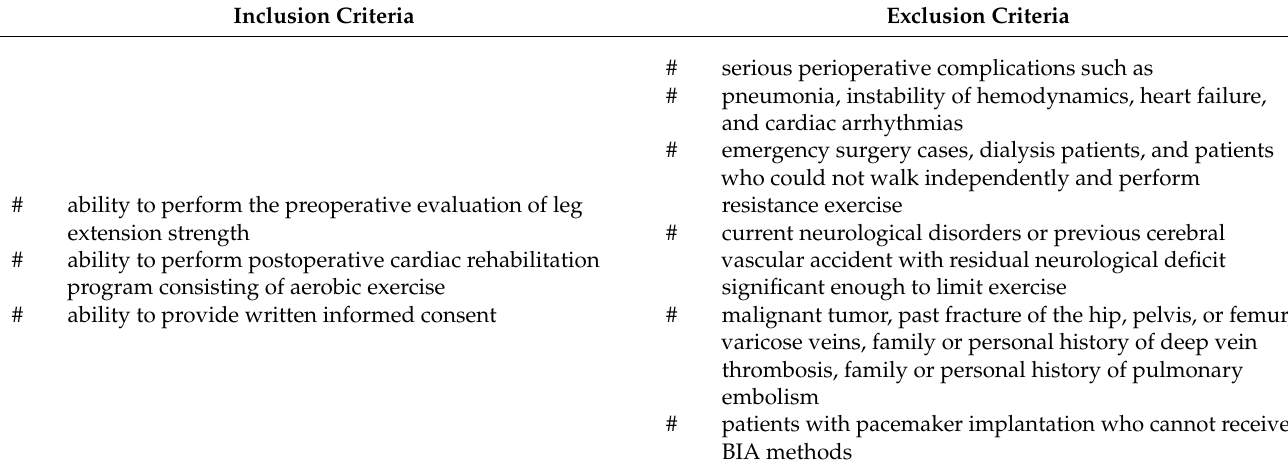
Table 1. Inclusion and exclusion criteria.